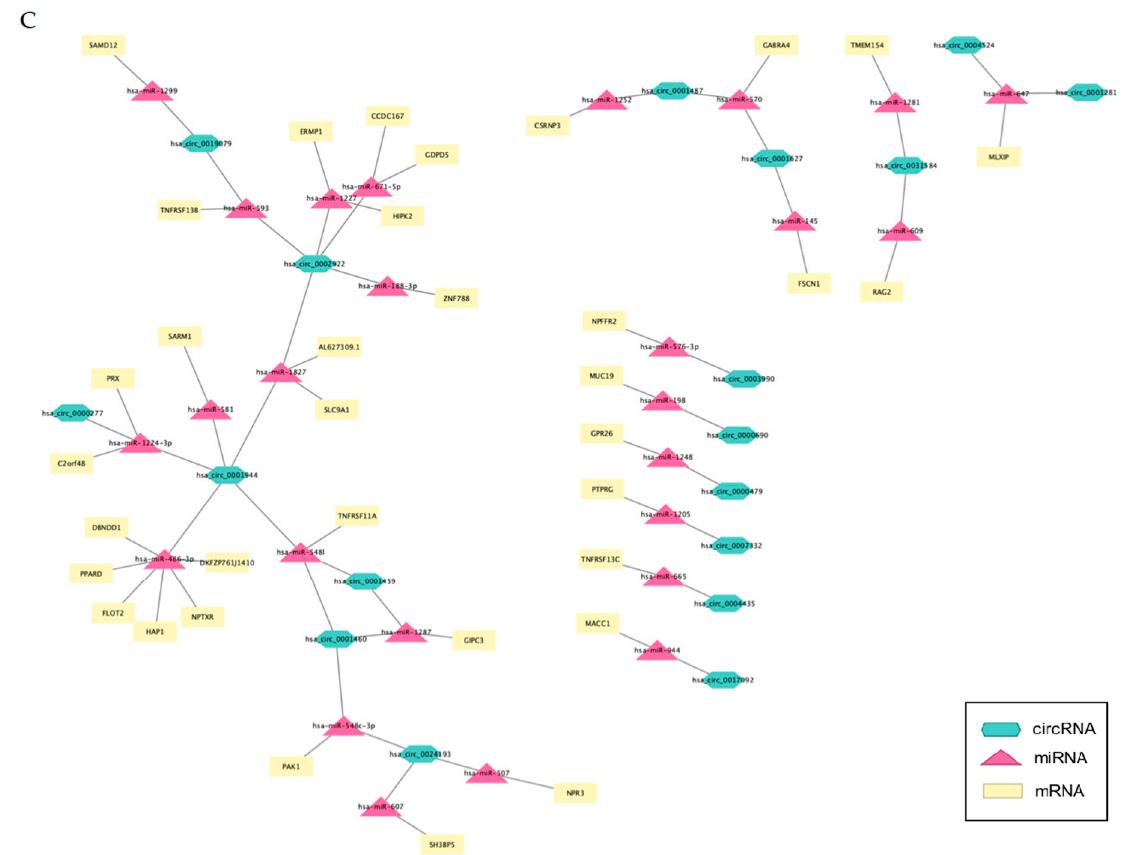
Figure 7. mRNA–circRNA–miRNA networks. Networks including circRNAs “very possibly” acting as miRNA sponge (Type 2) ( A ), “possibly” acting as miRNA sponge (Type 1) ( B ) and “not” acting as miRNA sponge (Type 0) ( C ). The network type 2 consists of 14 circRNAs, 20 miRNAs and 29 genes were generated by Cytoscape 3.9.1. The network Type 1consists of 7 circRNAs, 8 miRNAs and 12 genes and was generated by Cytoscape 3.9.1. The Network Type 0, consisting of 18 circRNAs, 26 miRNAs and 35 genes, was generated by Cytoscape